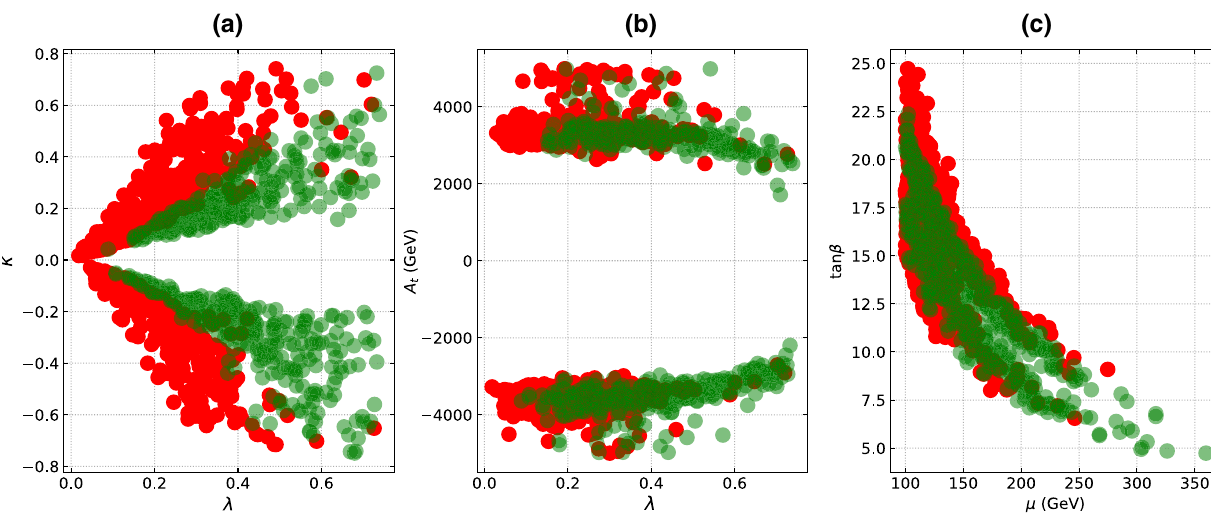
Fig. 1 SI (SD) cross section for DM-nucleon scattering versus DM mass considering the constraints from the DM relic density, Higgs data from LEP, Tevatron and LHC experiments. In the left plane, the red